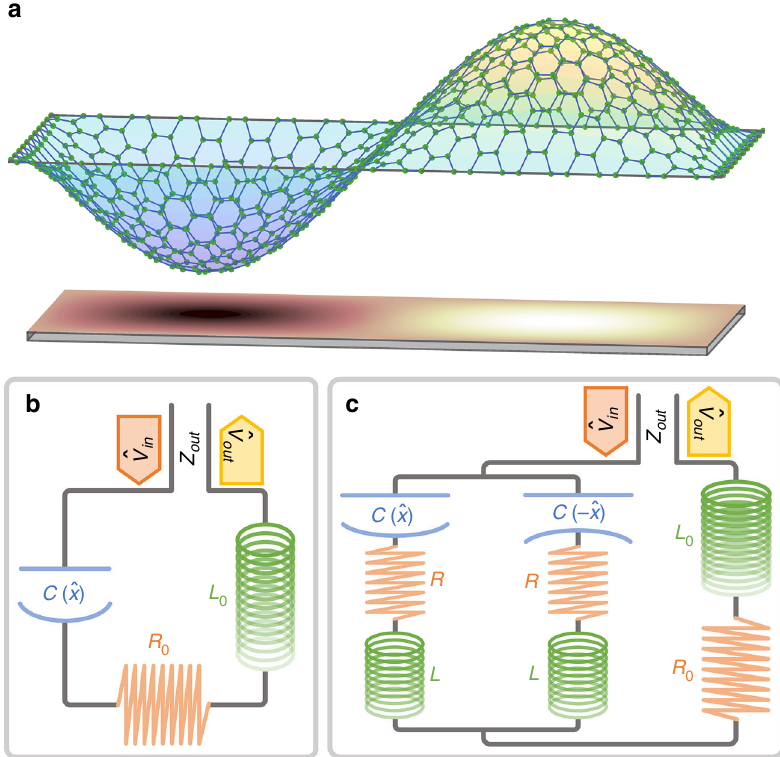
Fig. 1 Experimental setup. a Sketch of a capacitor with an oscillating plate, here represented by a graphene membrane. We consider an antisymmetric (2, 1) mechanical mode. b RLC oscillator formed by the inductance L 0 , resistance R 0 , and position-dependent capacitance C ð ^ x Þ . The circuit is driven by the input voltage ^ V through a transmission line of impedance Z out . ^ V is the re fl ected signal. c Model circuit for an RLC system where the capacitor has the same in out form as in a . The membrane has a vanishing linear coupling to the symmetric electrical mode used for probing the system. The antisymmetric mode, residing in the small loop containing parasitic inductances L and resistances R , describes the redistribution of charge on the